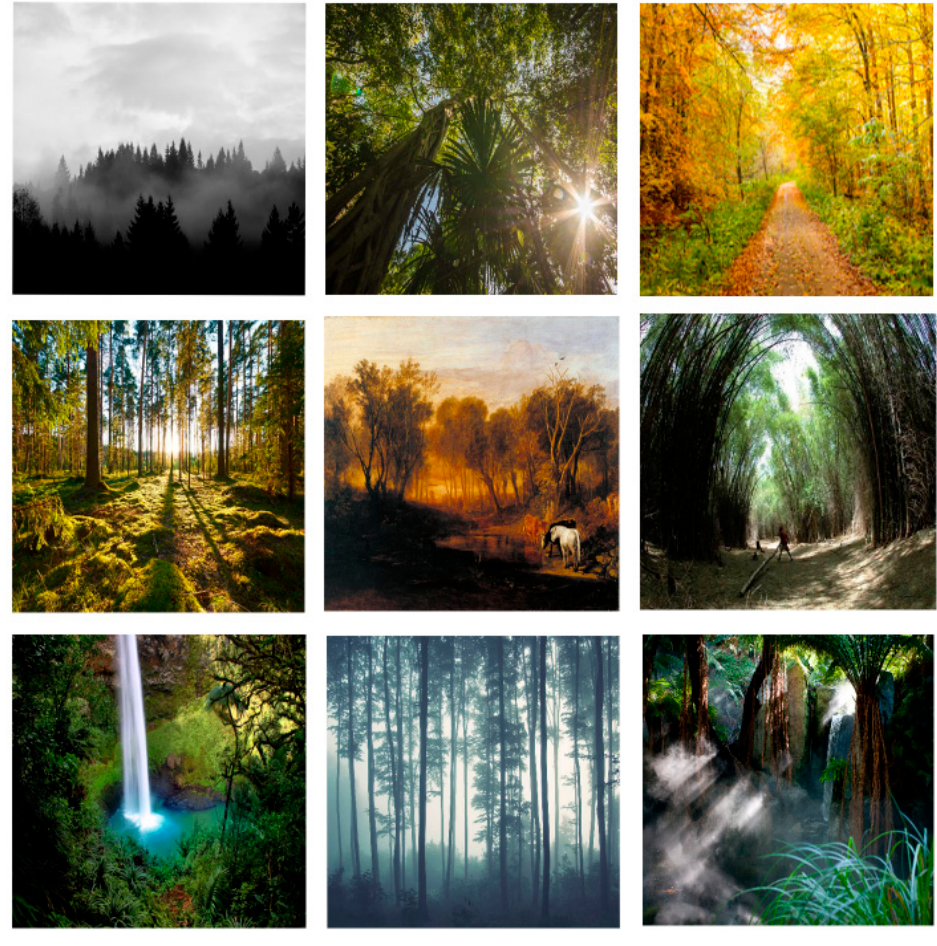
Figure 5. Forest fire-like lights (non-fire) [6].